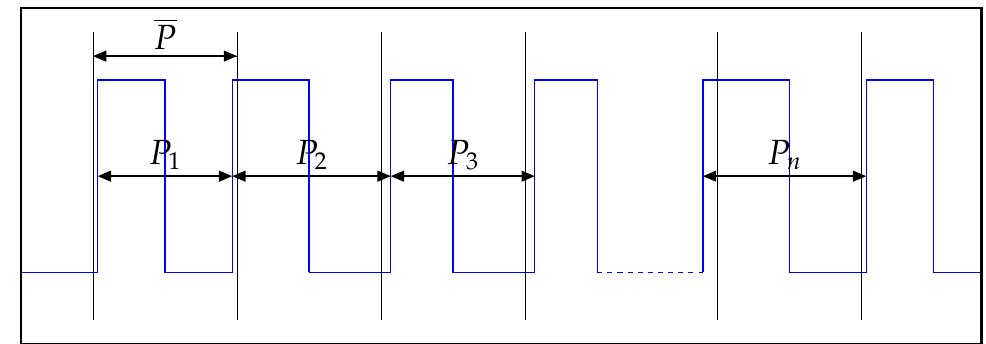
Figure 11. Periodic Jitter.